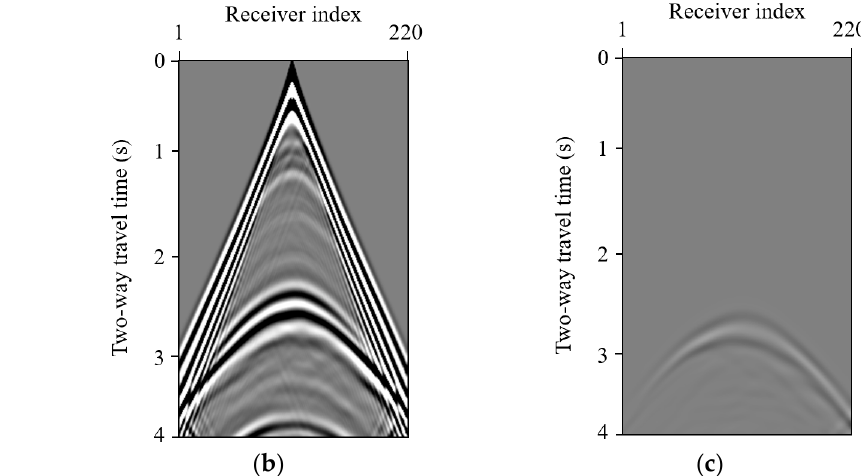
Figure 5. Shot gathers ( a ) before and ( b ) after injection, and ( c ) the subtraction between pre- and post-injection.